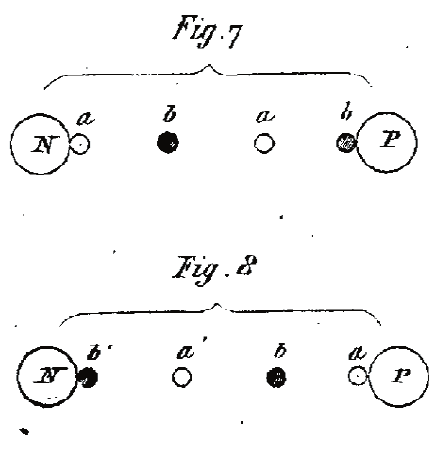
Figure 8. Drawing which illustrates Michael Faraday´s concept of the electrophoretic migration of the ions during electrolysis. In the upper scheme anions a and a´ migrate towards the anode, P , cations b and b´ to the cathode, N . They are moving parallel to the lines of forces, which fill the space between the two electrodes. For details, see main text, quoted sub-section 519. in Faraday´s Fifth Series . Taken from ref . 109